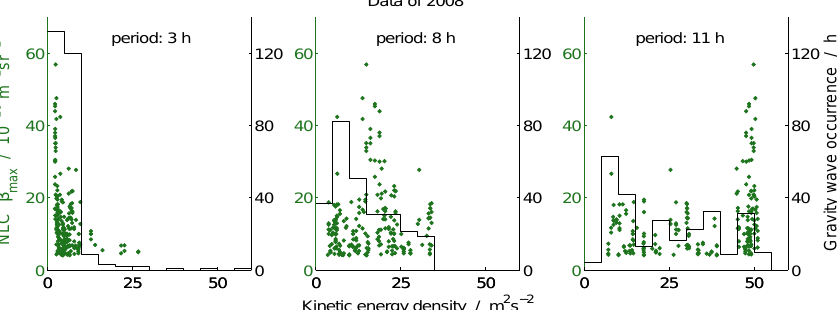
Fig. 6. NLC brightness vs. kinetic energy density for data of 2008 and three different periods (3h, 8h, 11h). The step plot shows the histogram of gravity wave occurrence as in Fig. 2c.